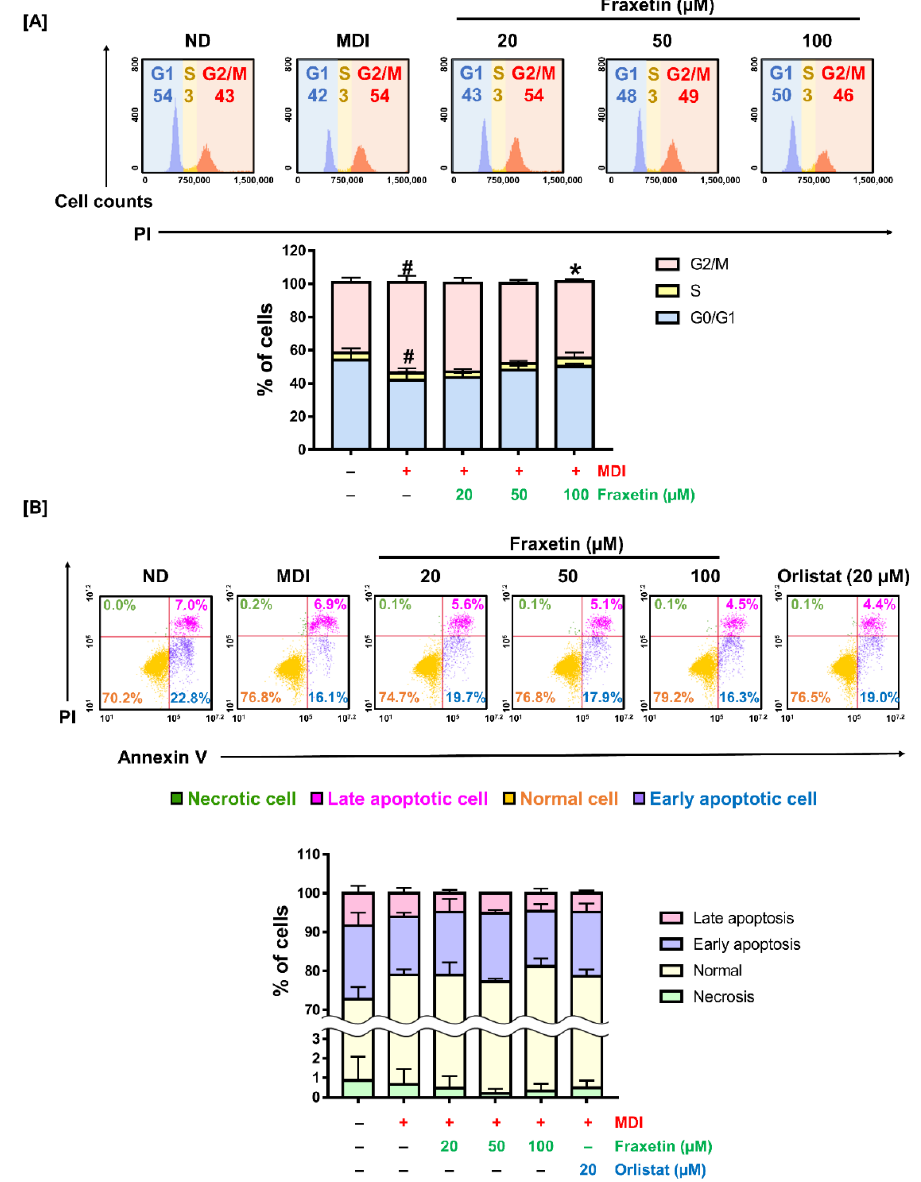
Figure 4. Fraxetin triggers cell-cycle shifts without apoptotic cell death. ( A ) Preadipocytes were incubated with diverse doses of fraxetin in an MDI induction medium for 2 days. After fixation, cells were stained by PI-retaining ribonuclease A and evaluated using flow cytometry. Each value in the histogram was determined by counting 10,000 events. The ratio of cells at each phase was represented in each histogram. ( B ) The impact of fraxetin with respect to apoptosis in MDI-treated cells was evaluated with Annexin V and PI double-staining assay. Confluent preadipocytes were incubated with different concentrations of fraxetin in an MDI induction medium for 2 days. Cells were treated by PI and Annexin V and assessed by flow cytometry. The number of cells in each dot plot was 10,000. All data were obtained in triplicate. The crosshatch mark indicates significant differences among the nondifferentiated group and others (# p < 0.05). The asterisk symbol represents significant differences between the MDI-treated group and others (* p < 0.05), as verified using one-way analysis of variance (ANOVA), followed by Dunnett’s post hoc analysis.